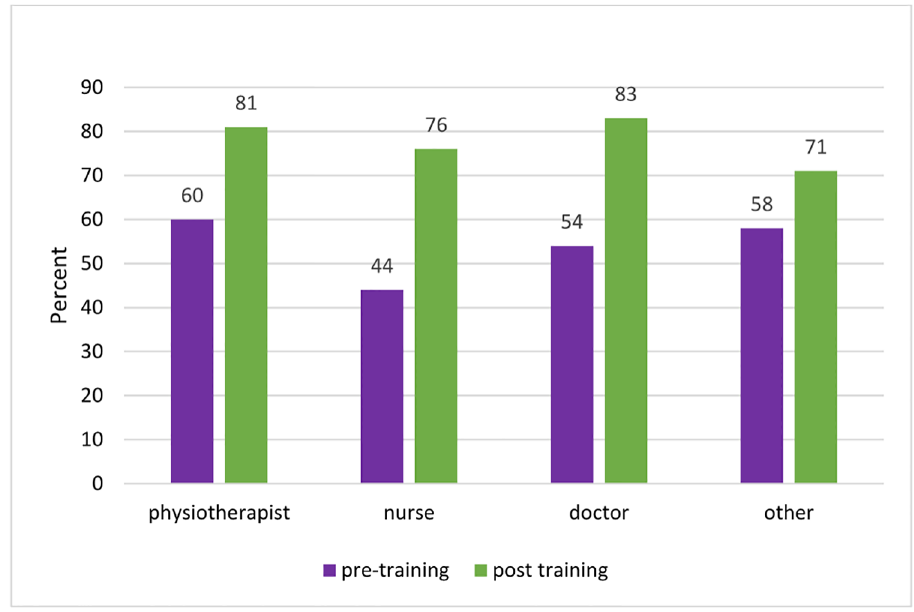
Fig 2. Pre- and post-course knowledge performance by